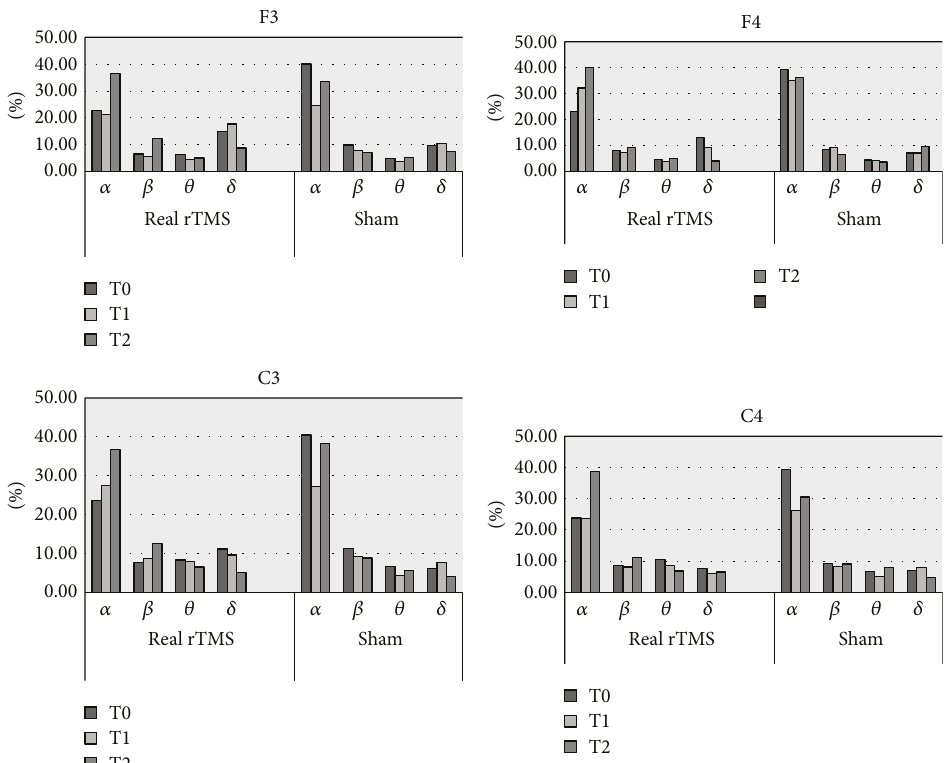
Figure 4: Grand average (5 patients, patients ’ numbers 1, 2, 3, 5, and 6) of delta, theta, alpha, and beta relative powers (%) prereal and postreal and presham and postsham rTMS at T0, T1, and